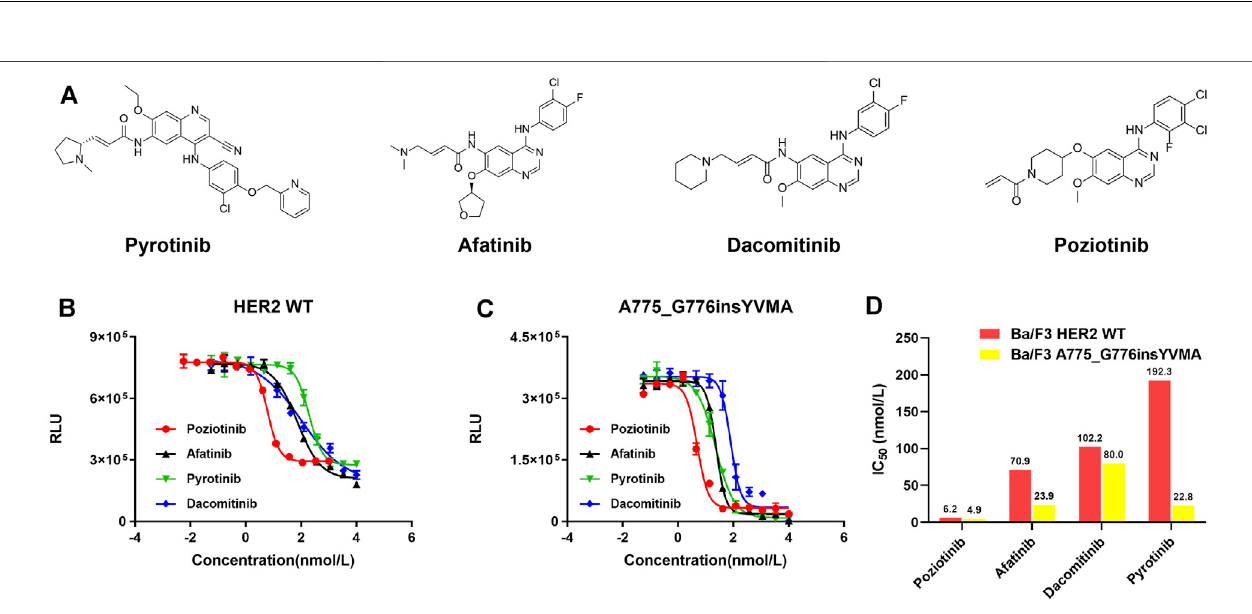
FIGURE 5 | HER2 -targeted TKIs pyrotinib, afatinib, dacomitinib, and poziotinib (A) were performed in cellular kinase inhibition assay to inhibit HER2 wild type (B) and A775_G776insYVMA (C) Ba/F3 cells. IC 50 values of above four inhibitors against HER2 wild type and A775_G776insYVMA cells (D) .